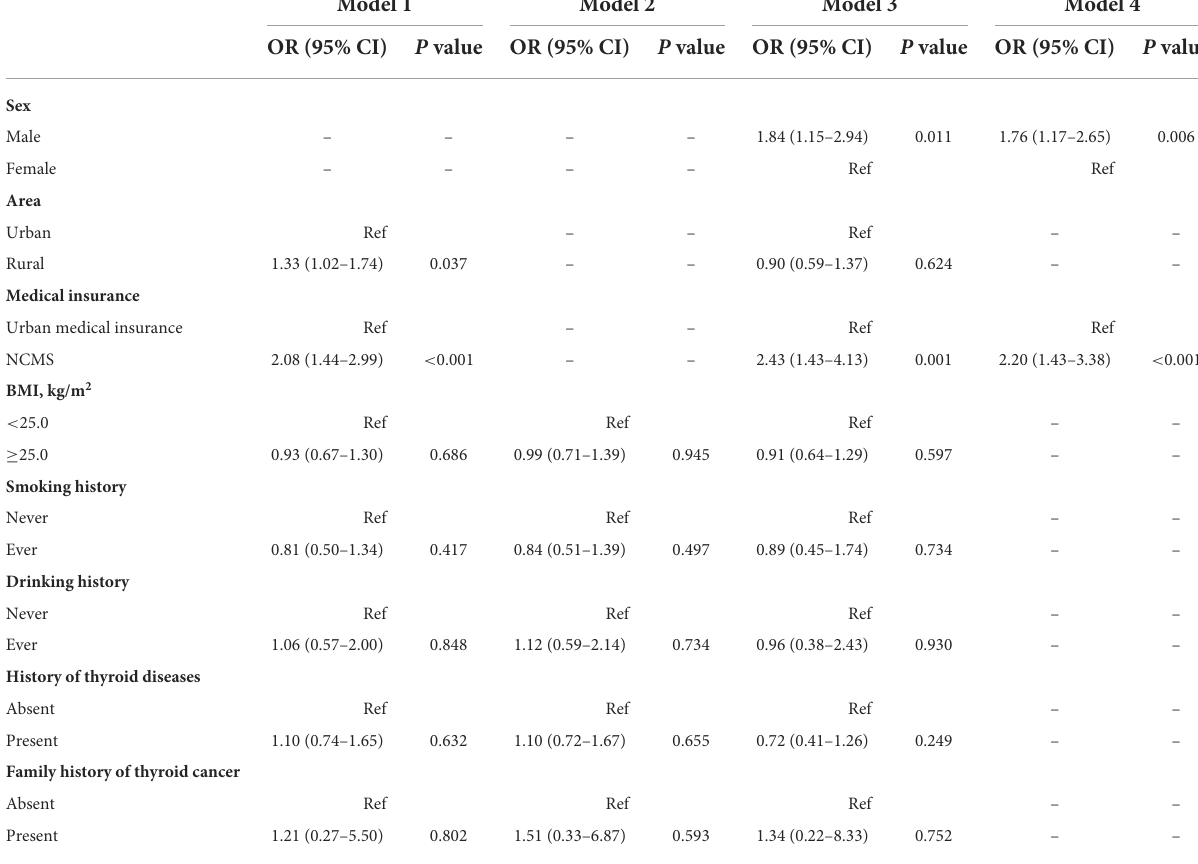
TABLE 2 Adjusted ORs (95% CIs) for late-stage DTC patients aged ≥ 45y.